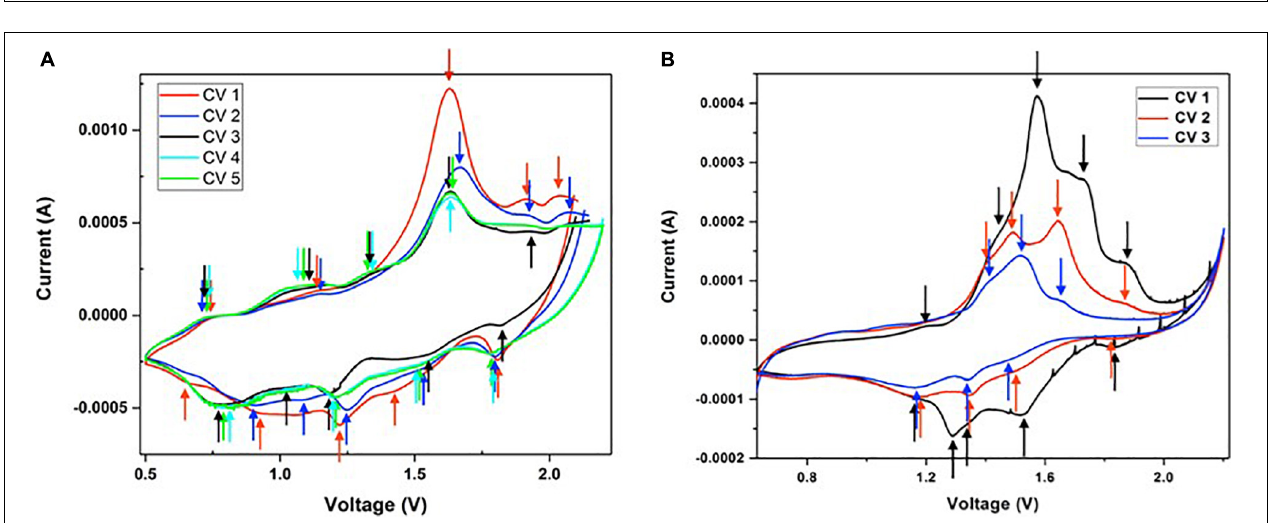
FIGURE 7 | (a) TEM, (b) HRTEM, and (c) SAED pattern of VOP1. (d) TEM, (e) HRTEM, and (f) SAED pattern of VOP2. The inset in panel (e) shows another crystal plane identified in a different region.